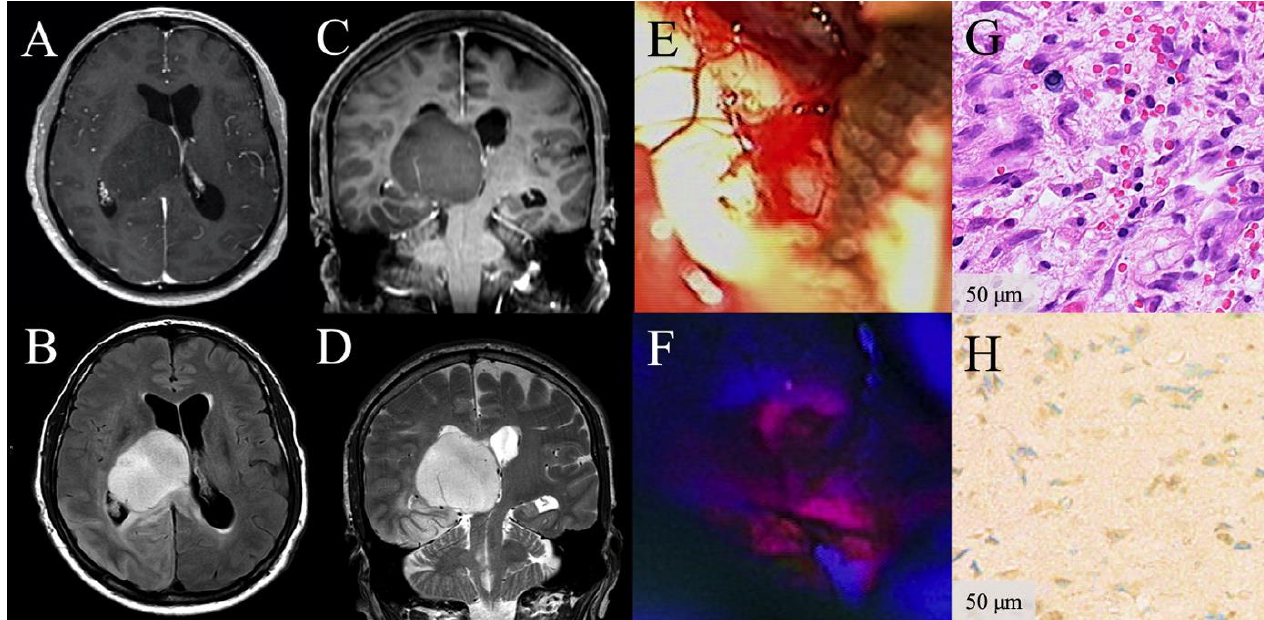
Figure 2. Illustrative clinical course of a patient with focal visible 5-aminolevulinic acid (5-ALA) fluorescence during surgery of a low-grade glioma. Preoperative contrast-enhanced (CE) magnetic resonance images demonstrate a radiologically suspected LGG in the thalamus without CE on T1-weighted axial ( A ) and coronal images ( C ), but hyperintensity on FLAIR ( B ) and T2-weighted sequences ( D ). Under white-light microscopy whitish glioma tissue is present ( E ). Under violet-blue excitation light, the corresponding area shows focal 5-ALA fluorescence ( F ). The corresponding histopathological sample reveals diffusely infiltrating astrocytoma WHO grade II tissue (H3K27 wildtype) according to the WHO 2016 criteria in the H&E stain and no malignant glioma tissue is found despite the visible fluorescence. ( G ). Immunhistochemical staining for IDH mutation ( H ) and sequencing for other IDH1 or IDH2 mutations were negative (IDH wildtype glioma) ( H ). This patient survived only 1.5 years and showed early radiological tumor progression 6 months after surgery.